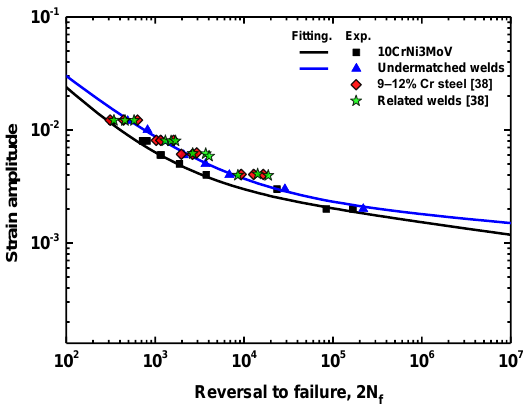
Figure 10. Comparison between Manson-Coffin curves of materials from test and reference [38].